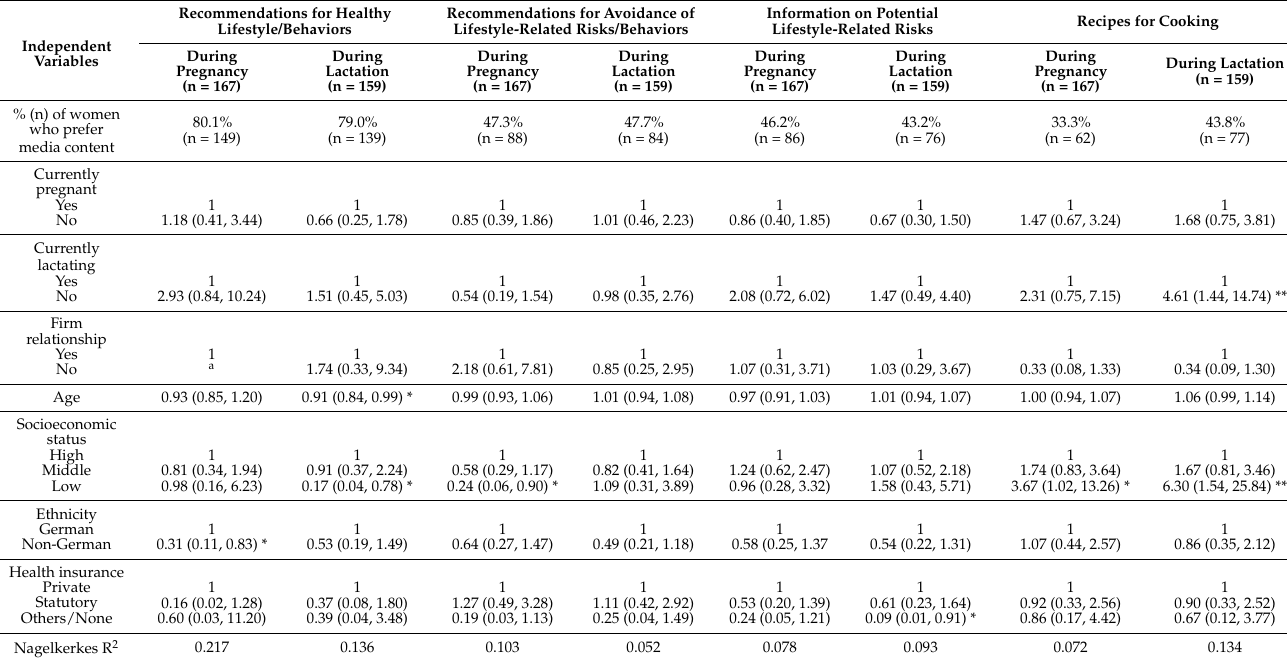
Table 4. Women’s preferred media content during pregnancy and lactation in association with independent variables, expressed in odds ratios (95% confidence